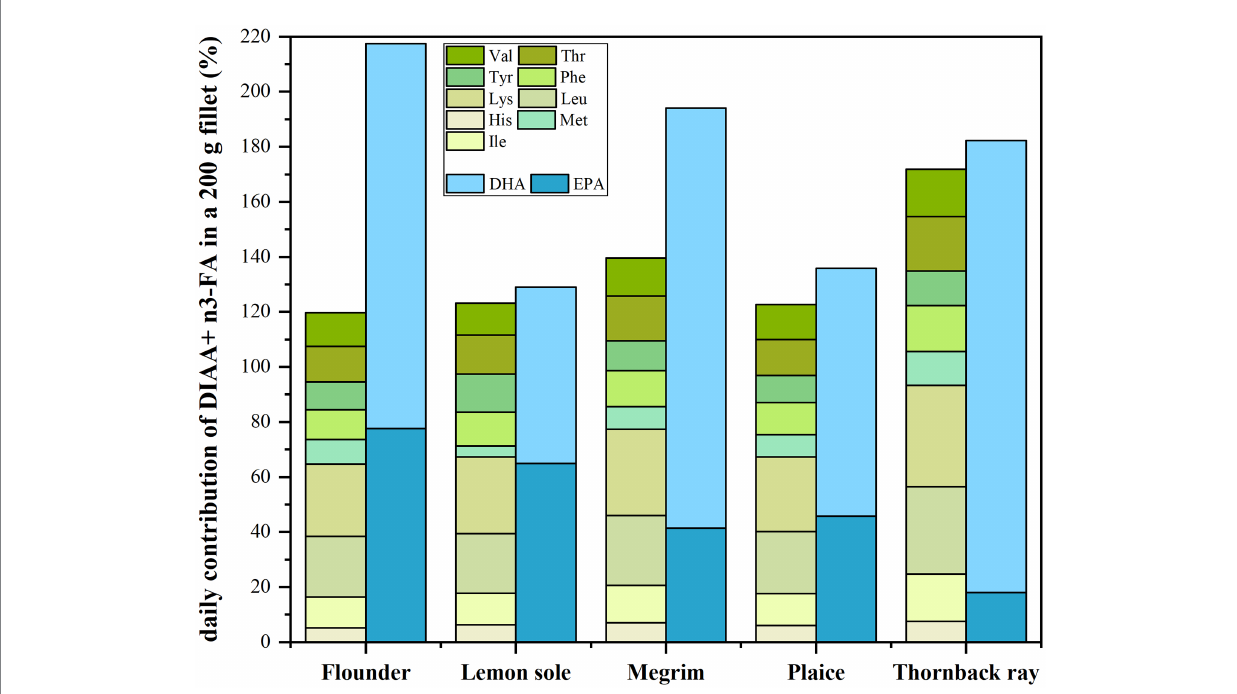
FIGURE 3 Given in green colors: average contribution of all DIAA to daily requirements for an 80 kg adult in a 200 g fillet portion by FAO, WHO (11); given in blue colors: average contribution of a 200 g fillet portion to cover the daily recommended intake of 250 mg DHA + EPA by EFSA